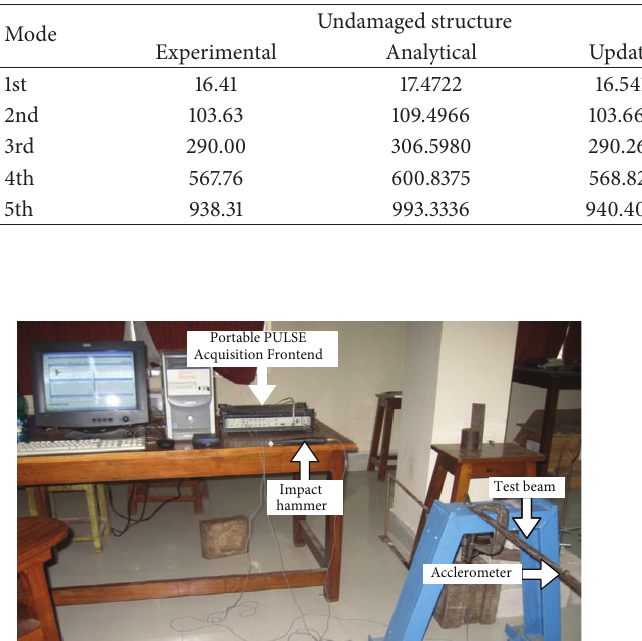
Table 1: Natural frequency of the structure (in Hz).